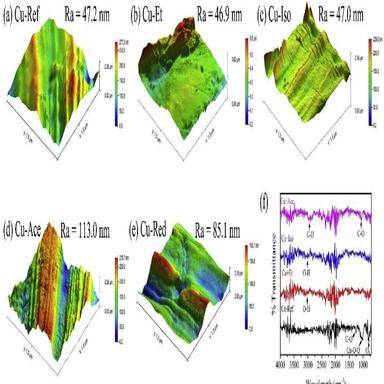
Atomic force microscopy images showing the roughness of the surface and surface roughness average (Ra). (a) Pristine Cu-foils. (b) Cu-foil after ethanol sonication treatment, (c) Cu foil after second cleaning step using isopropanol and after sonication. (d) Last cleaning process using acetone and after sonication (e) Cleaned Cu-foils after a reduction process. (f) FTIR analysis developed in each step of the Cu-foils cleaning process. (A colour version of this figure can be viewed online.)